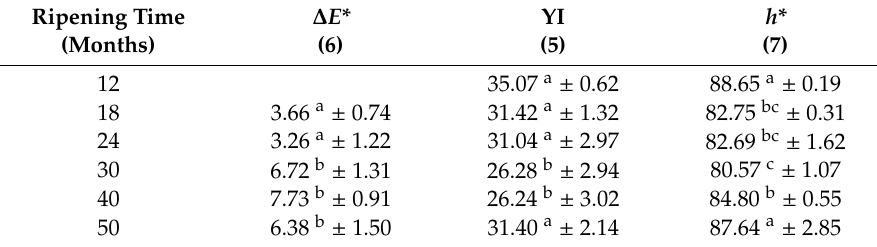
Table 5. Color parameters of Parmigiano Reggiano cheeses ripened from 12 to 50